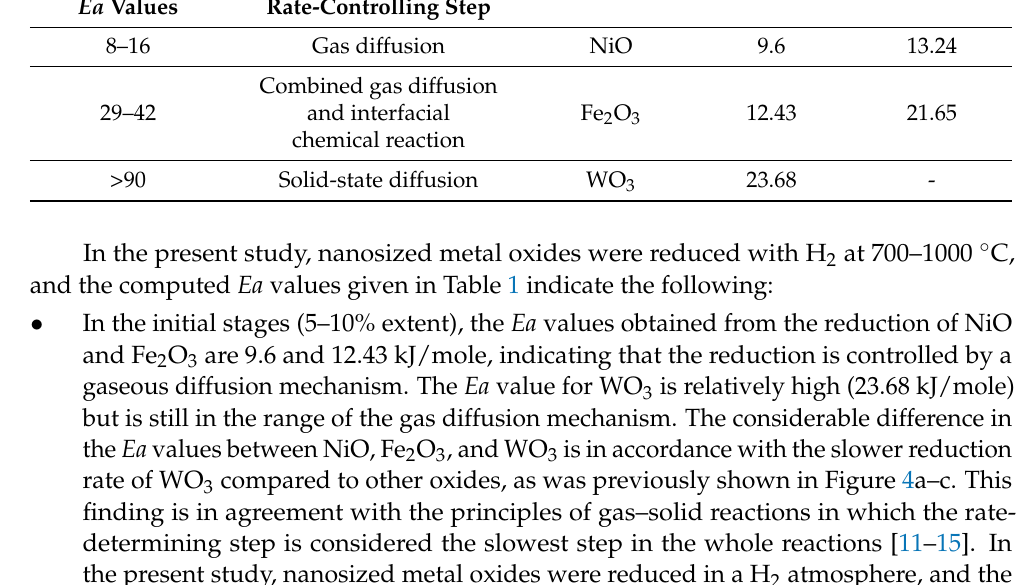
Figure 9. Arrhenius plots for the reduction of nanosized NiO, Fe 2 O 3 , and WO 3 with H 2 at 700–1000 ◦ C: ( a ) initial stages; ( b ) later stages. Table 1. Apparent activation energy ( Ea ) values for the reduction of nanosized metal oxides. Ea Values (kJ/mol) and the Corresponding Ea Rate-Controlling Step Oxide